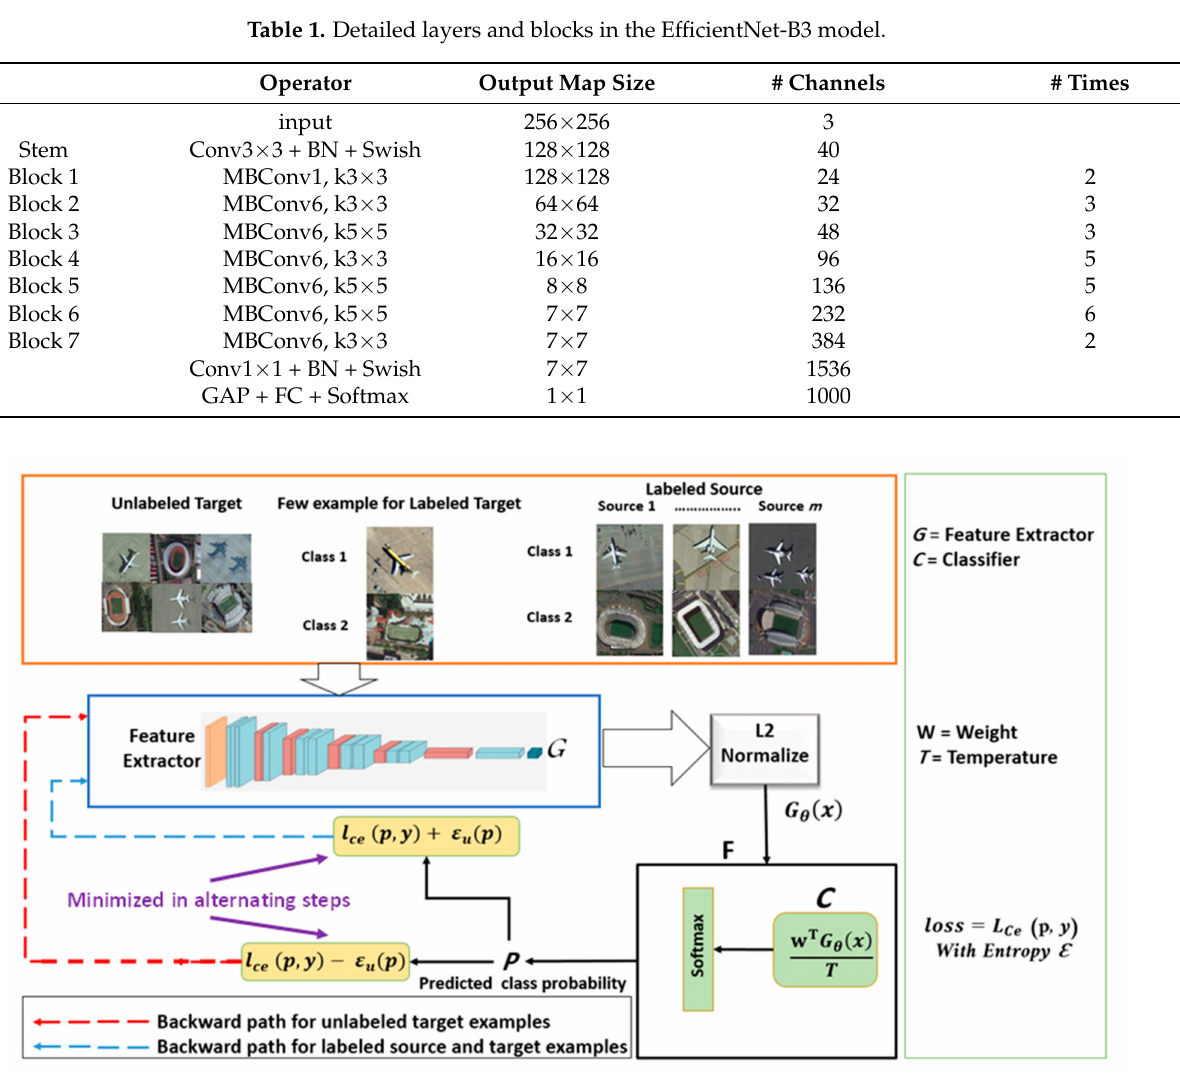
Figure 4. Overview of the proposed SSDAN